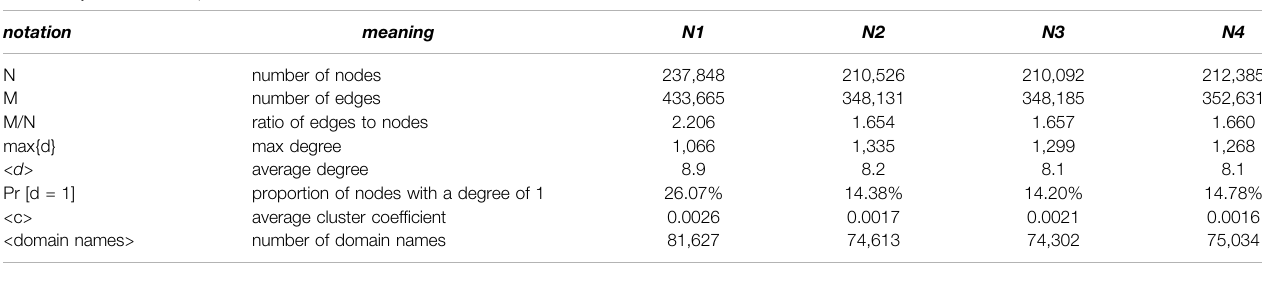
TABLE 1 | Characteristic parameters of N1 ∼